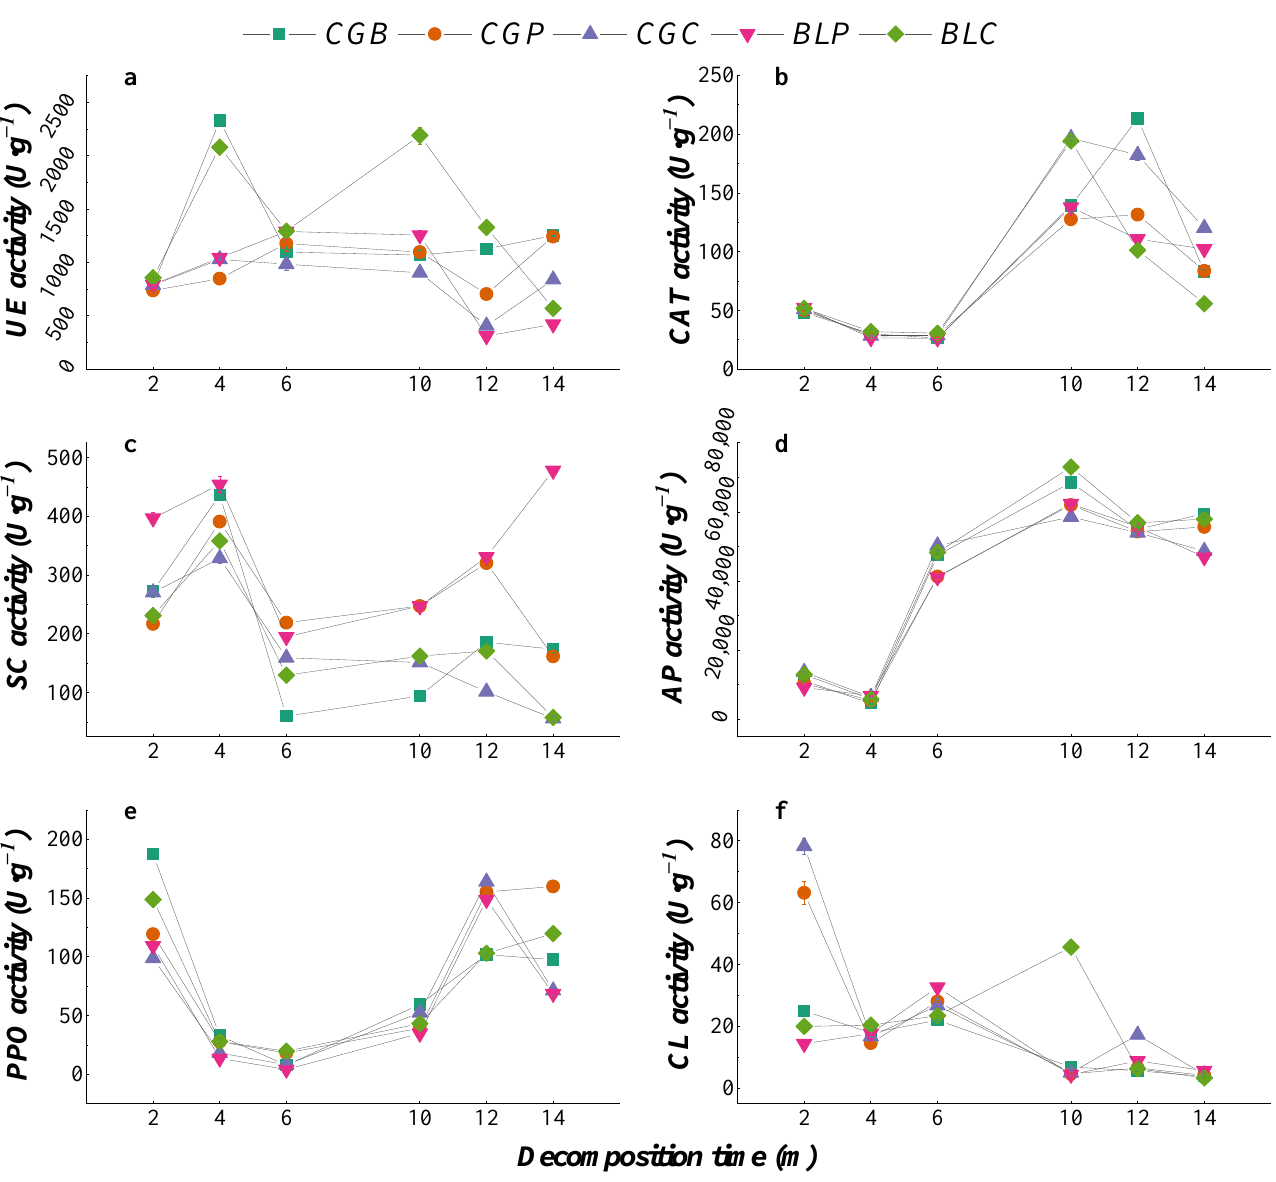
Figure 6. Dynamics of enzyme activities of different leaf litters in the decomposition process. ( a – f ) represents the Urease activity, Catalase activity, Sucrase activity, Acid phosphatase activity, Poly- phenol oxidase activity and Cellulase activity.